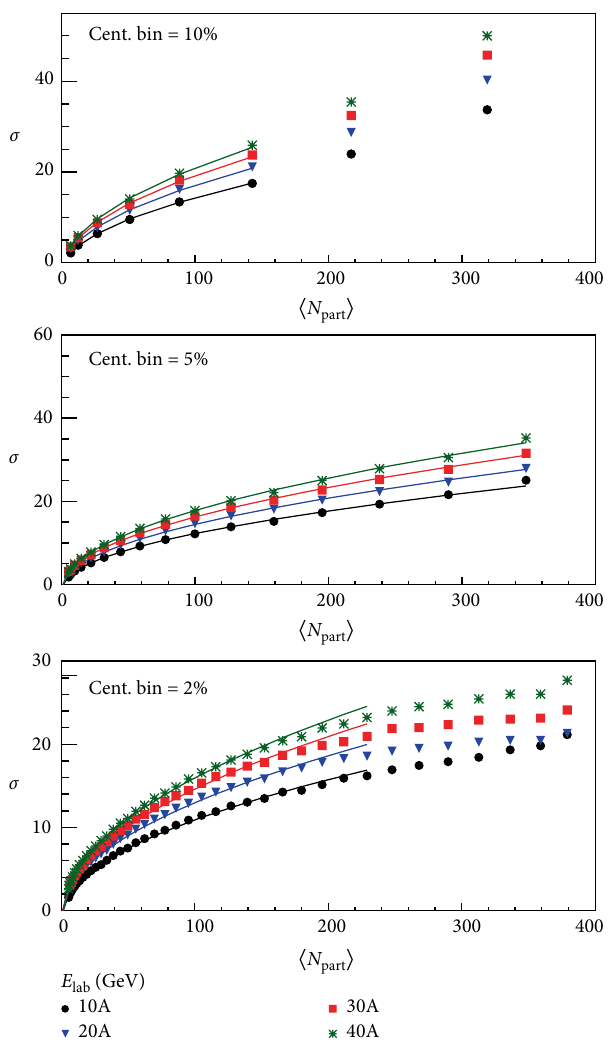
Figure 3: Variations of dispersion with mean number of participating nucleons. The lines are due to fits obtained using equation